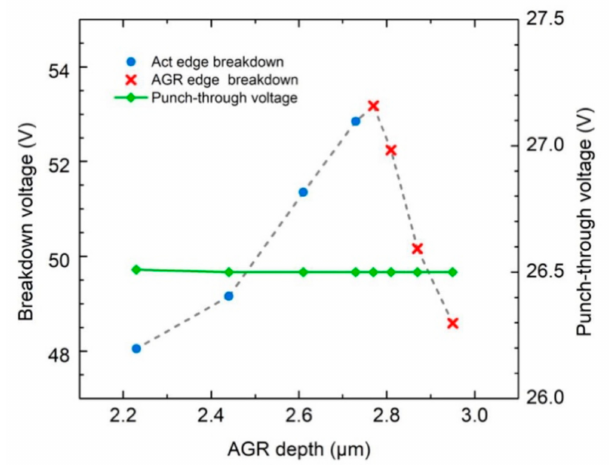
Figure 3. TCAD simulated breakdown voltage and punch-through voltage as functions of AGR depth. The punch-through voltage is independent of AGR